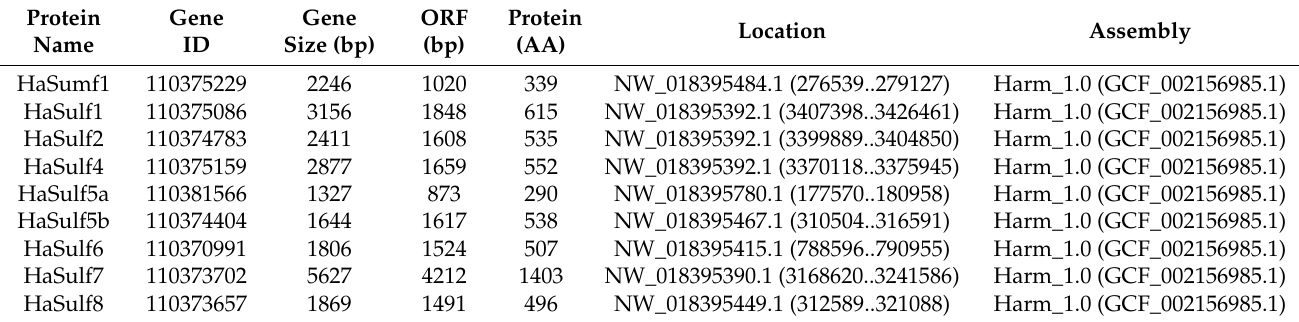
Table 2. Identification of HaSumf1 and HaSulfs.